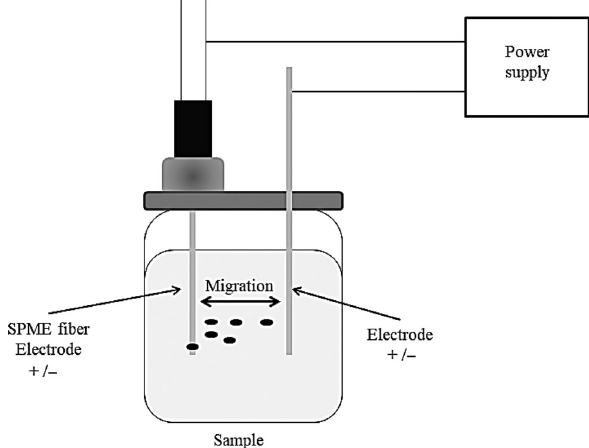
Figure 1: Diagram of an electrically enhanced SPME device. Tricyclic antidepressants in tap and reservoir water were analyzed using an electrically enhanced SPME method. Different conventional SPME fibers (PA, CAR/PDMS, DVB/CAR/PDMS, and PDMS/DVB) were eval- uated, and the best responses were obtained with a PDMS-coated fiber used as a cathode and a platinum wire as an anode. Extraction was carried out for 10 min, and was 10 – 170 min shorter than other reported methods. Recoveries ranged from 73.9% to 93.4% (Xu and Lee